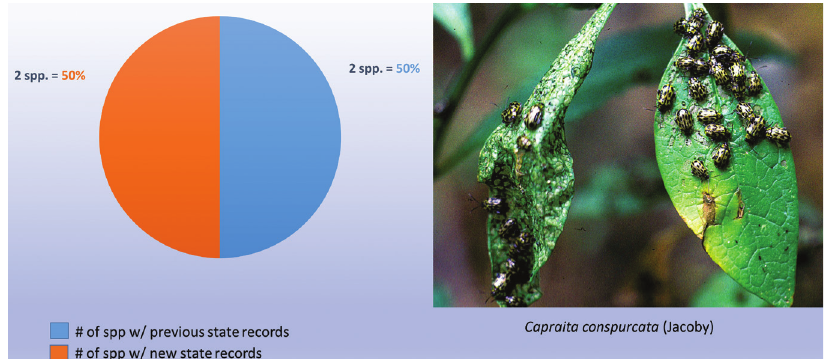
Figure 3. Capraita Bechyné new state records versus previously recorded state